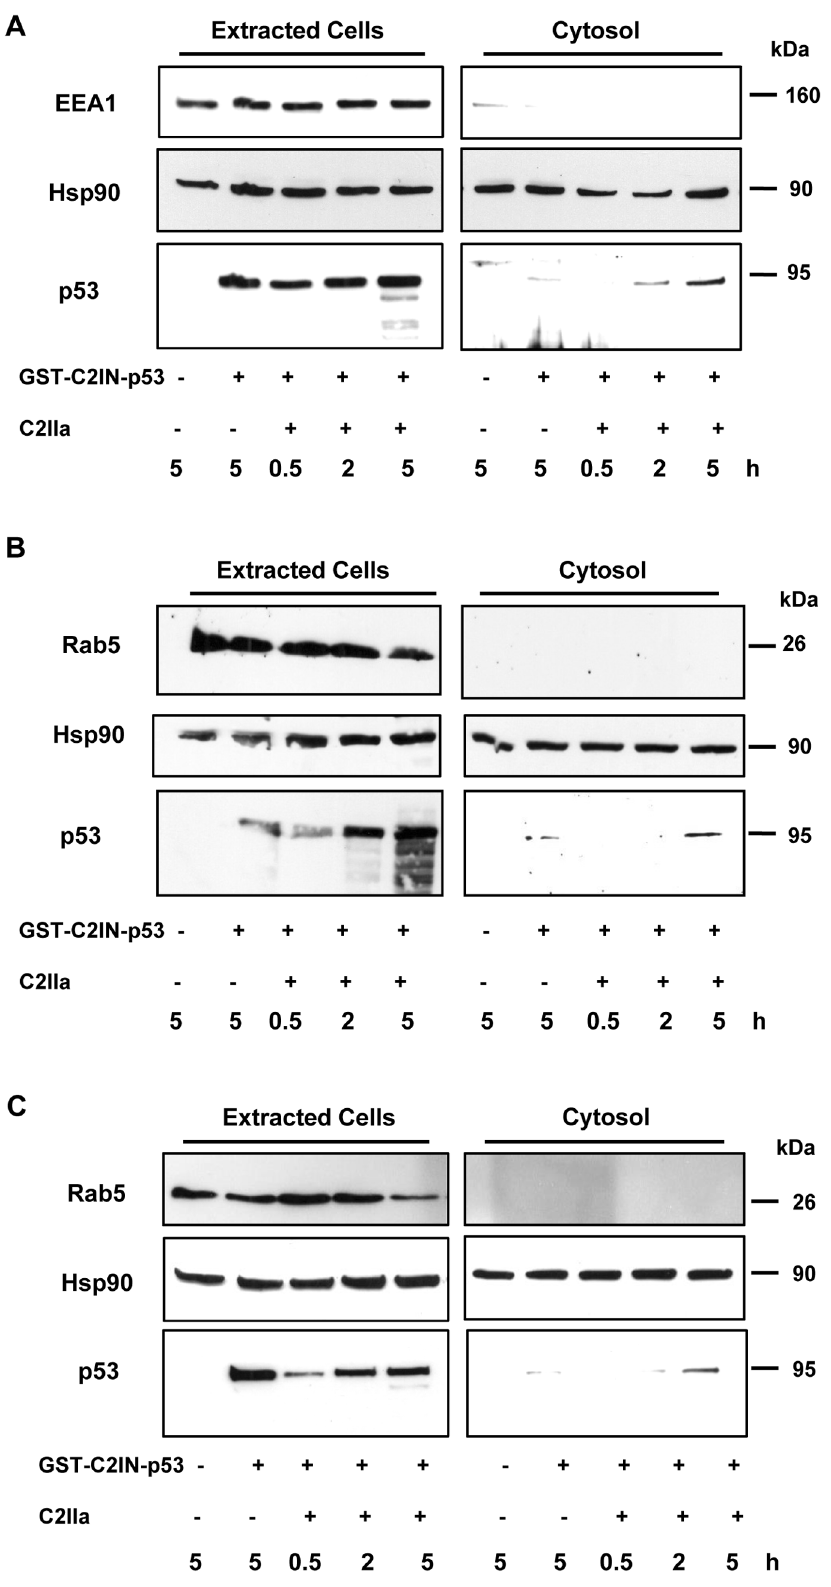
Figure 3. C2IIa-mediated delivery of C2IN-p53 into cancer cells. A. Uptake of C2IN-p53 into HeLa cervix carcinoma cells monitored by cell fractionation. HeLa cells were incubated with GST-C2IN-p53 and C2IIa for up to 5 h. Thereafter, digitonin-based cell fractionation was performed and extracted cells as well as cytosolic fractions were subjected to SDS-PAGE and subsequent Western blotting. Internalized GST-C2IN-p53 was detected